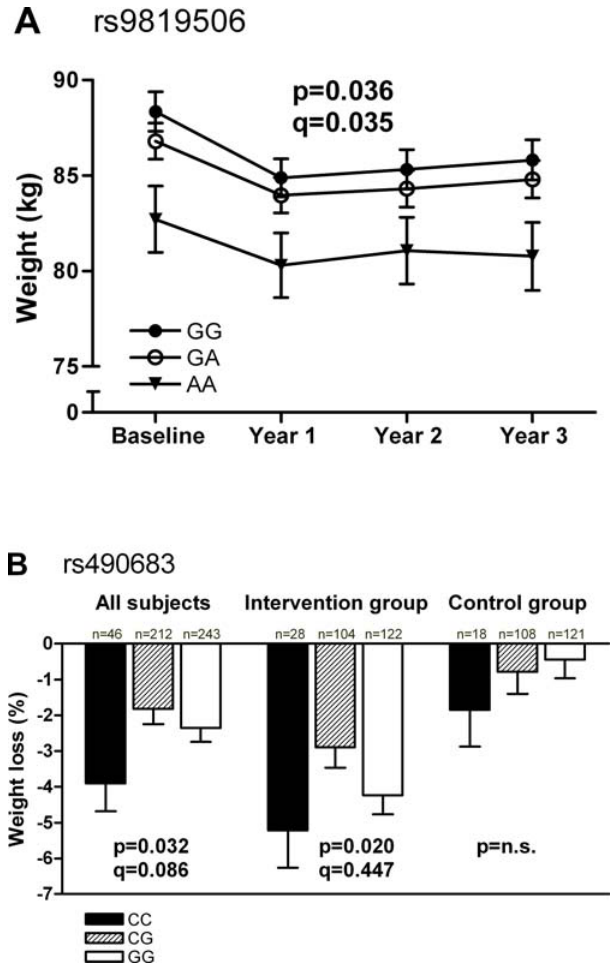
Figure 2. Weight and weight loss according to rs9819506 and rs490683 genotypes in DPS. A. Weight according to rs9819506 genotypes in the entire study population. Mean 6 SEM are estimated marginal means calculated from repeated measures ANOVA with sex and age as significant covariates. rs9819506-GG (n=171, filled circles); rs9819506-GA (n=200, open cirlces); rs9819506-AA (n= 59, filled triangles); pair-wise comparisons: GG vs. GA p=1.000, GG vs. AA p=0.030, GA vs. AA p=0.116. B. Relative weight loss according to the different genotypes of rs490683 in all subjects and separately in intervention and control group. rs490683-CC (black bars); rs490683-CG (striped bars); rs490683-GG (white bars). The q-value denotes the false discovery rate (FDR) and is reported only for p , 0.1. n.s.,